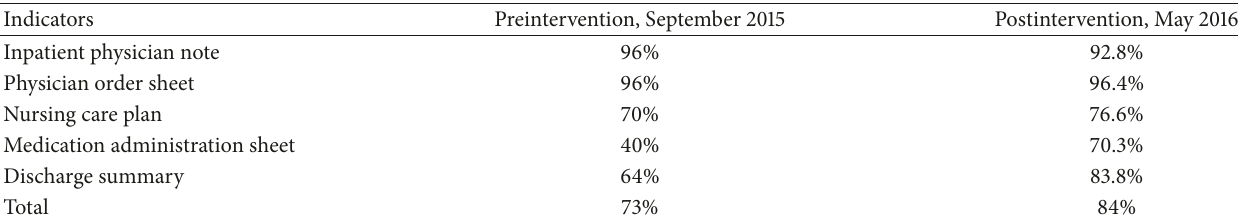
Table 1: Pre- and postintervention changes in medical record completeness in Menelik II Referral Hospital, Addis Ababa, Ethiopia, May 2016.